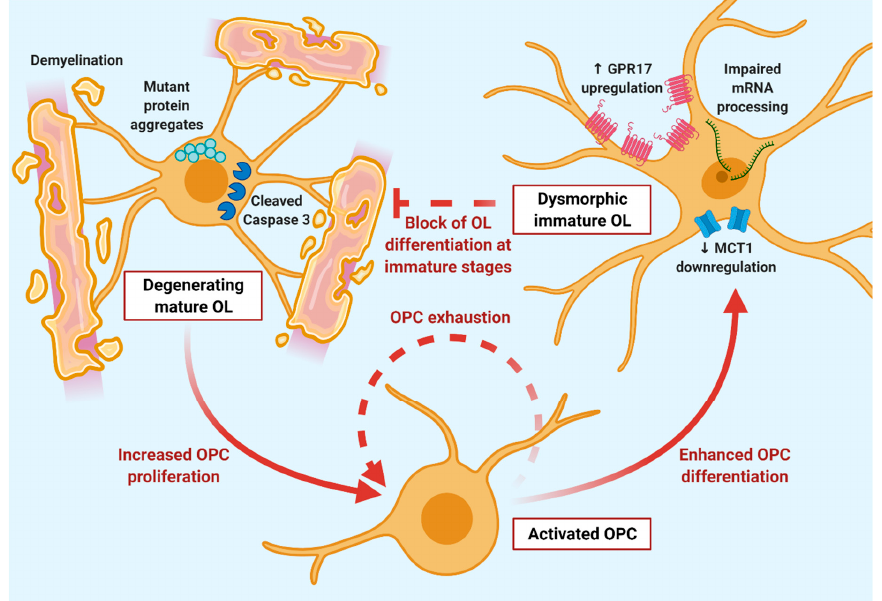
Figure 2. Oligodendrocyte (OL) dysfunction in ALS. In experimental models and patients affected by ALS, pathological alterations of myelinating OLs have been observed, i.e., the formation of toxic aggregates of ALS-related mutant proteins. Consequently, OLs start to degenerate, as confirmed by typical signs of apoptosis like cleaved caspase 3 reactivity, leading to axonal demyelination. In response to myelin disruption, oligodendrocyte precursor cells (OPCs) increase their proliferation rate and undergo differentiation to replace dying cells with new mature OLs. However, these newly- formed OLs are characterized by abnormal upregulation of the GPR17 receptor, likely contributing to inhibit their terminal maturation, and by the downregulation of the monocarboxylate transporter MCT1, required for supplying lactate and other nutrients to motor neurons (MNs). A defective processing and trafficking of myelin-related mRNAs was shown to further contribute to impaired remyelination. Hence, these alterations result in the generation of dysmorphic and immature OLs, unable to remyelinate axons and to restore their trophic support to MNs, and in the exhaustion of the reserve pool of OPCs due to increased turnover